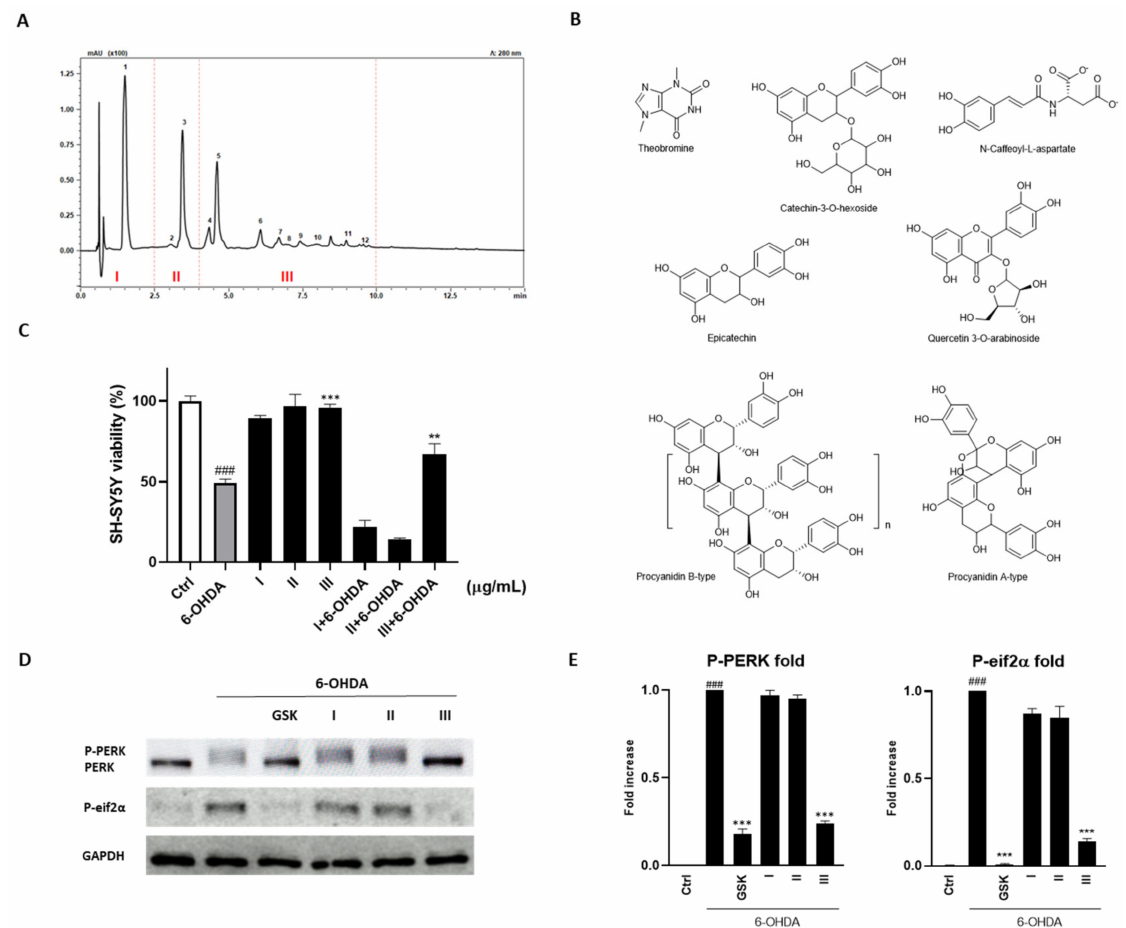
Figure 3. ( A ) Chromatographic profile acquired by UHPLC-PDA ( λ = 280 nm) of phytochemi- cal compounds in cocoa ethanolic extract. Identified peaks are: fraction I: (1) Theobromine; frac- tion II: (2) Catechin-3-O-hexoside; (3) N-Caffeoyl-L-aspartate; fraction III: (4) Procyanidin B-type; (5) Epicatechin; (6) Procyanidin B-type trimer; (7) Procyanidin B-type tetramer; (8) Procyanidin B-type tetramer (isomer); (9) Procyanidin B-type pentamer; (10) Procyanidin B-type hexamer; (11) Procyanidin A-type hexoside; (12) Quercetin 3-O- arabinoside. ( B ) Main components of the cocoa fractions. ( C ) PB assay showed the neuroprotective effect of fraction III against 6-OHDA- induced cytotoxicity. ( D , E ) Effect of fraction III on PERK and eif2 α phosphorylation. Results are showed as mean ± standard deviation (SD) from three independent experiments. ### denotes p < 0.001 vs. Ctrl; **, *** denote respectively p < 0.01 and p < 0.001 vs.